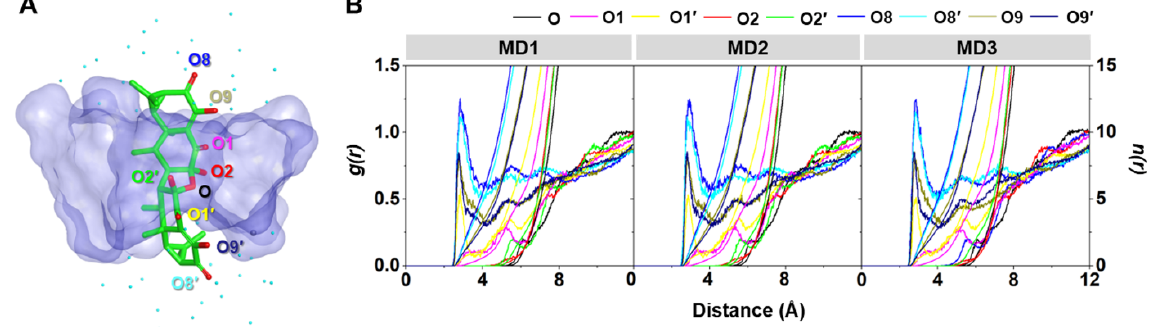
Figure 9. ( A ) Final MD snapshot of the AA/DM β CD complex showing the oxygen atoms (O, O1, O1 ′ , O2, O2 ′ , O8, O8 ′ , O9, and O9 ′ ) of AA and the surrounding water molecules (cyan dot) within 5 Å of AA. ( B ) RDF of water oxygen atoms around the oxygen atoms of AA in complex with DM β CD for three independent simulations (MD1–3). Table 3. n ( r ) up to the first minimum for the oxygen atoms of AA inside the DM β CD hydrophobic cavity.